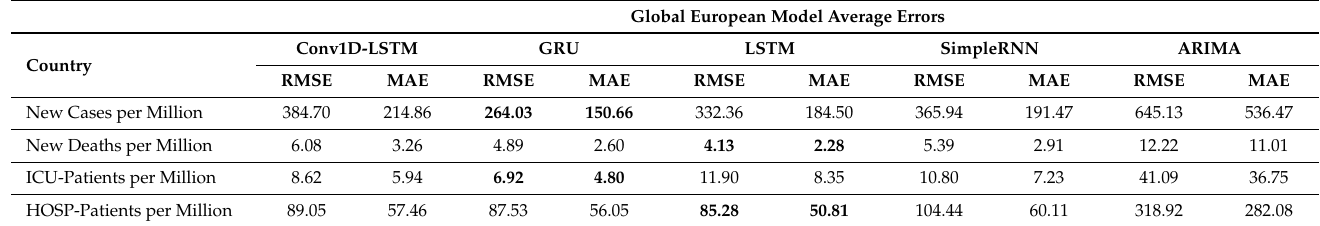
Table 7. Averaged RMSE and MAE errors for the global European Model. Traditional approaches, such as ARIMA, are also included. The minimum MAE and RMSE errors are highlighted with